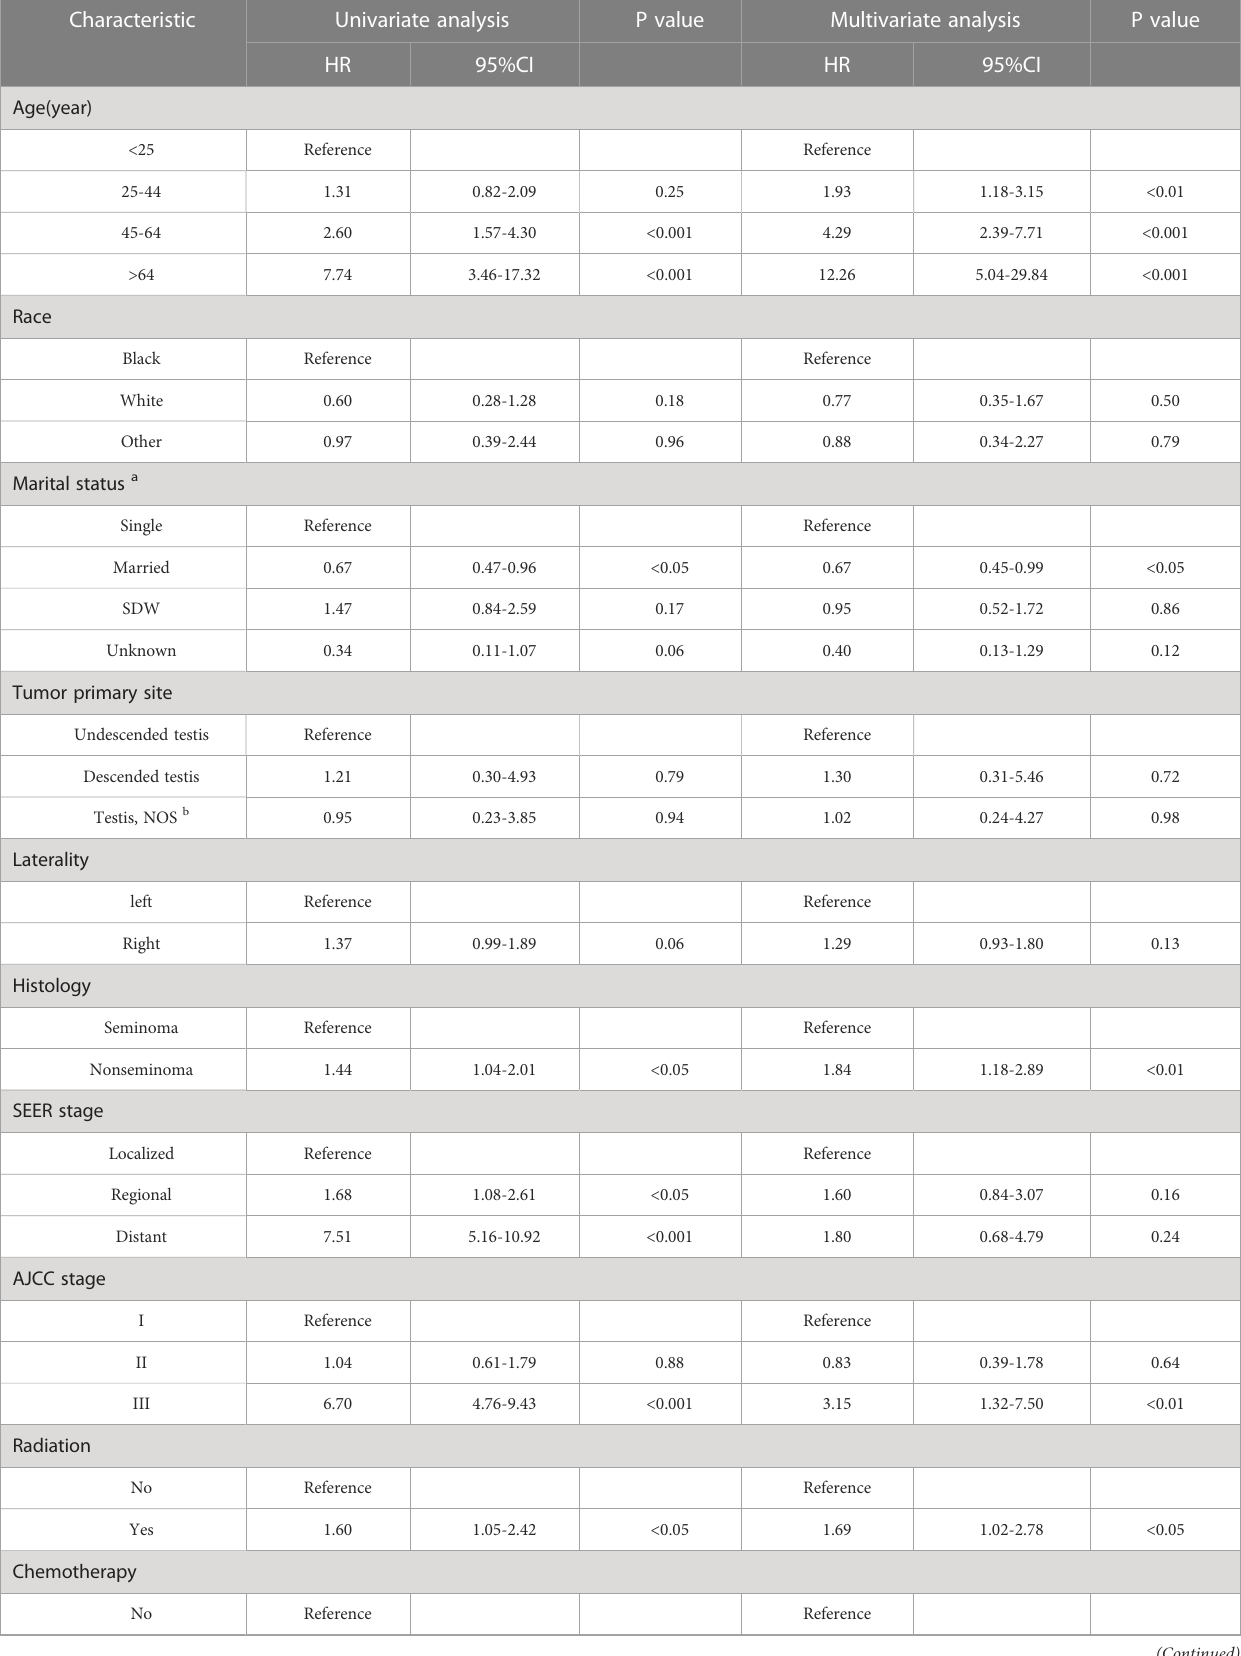
TABLE 2 Univariate and multivariate Cox analyses of the overall survival in patients with